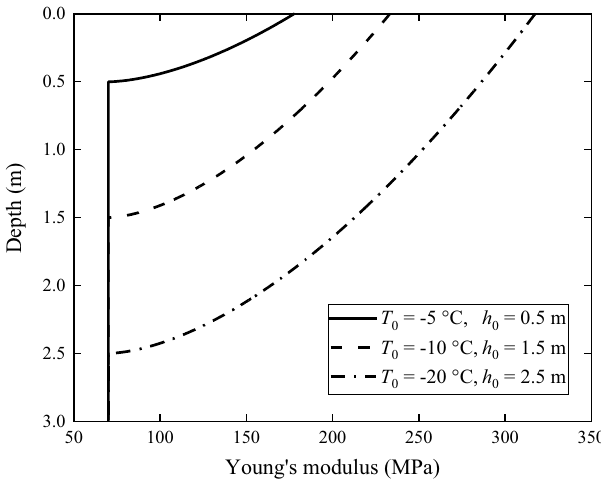
Figure 2. Young’s modulus of the frozen ground as function of